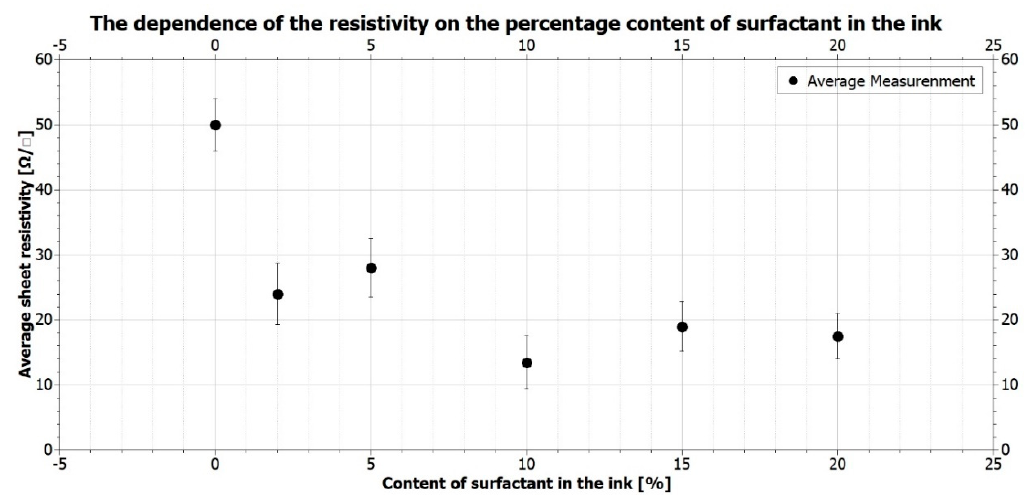
Figure 6. The dependence of the resistivity on the percentage content of the surfactant in the ink.